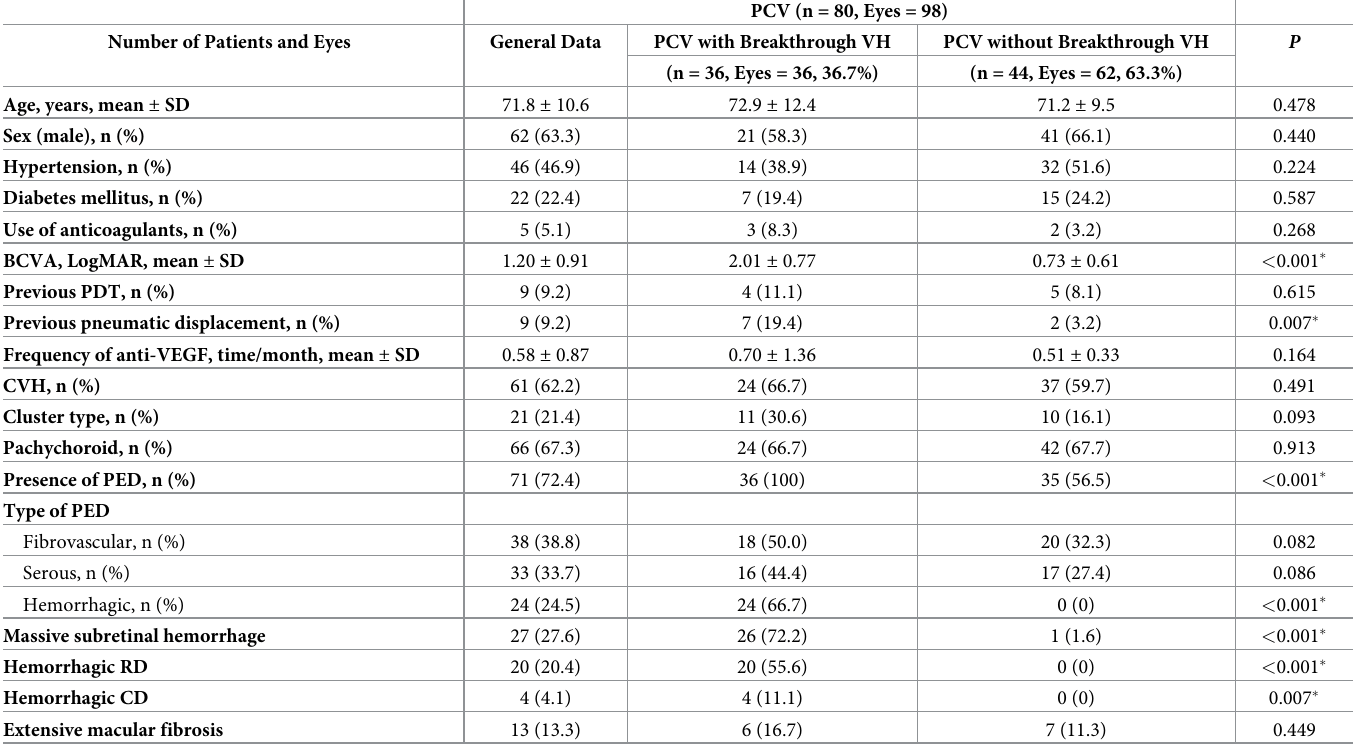
Table 1. Baseline demographic and clinical characteristics of patients with polypoidal choroidal vasculopathy.